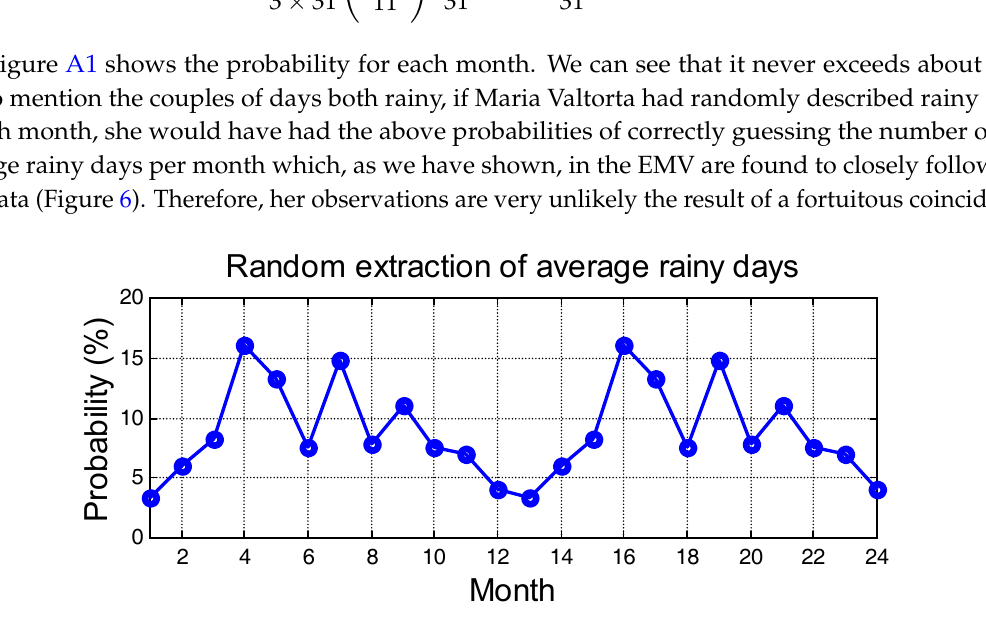
Figure A1. Probability of randomly finding the average number of rainy days for each month, according to the IMS daily rainfall data bank in the years from 1990 to 2015, concerning 184 localities of the Holy Land. Notice that each annual cycle is repeated twice for showing continuity.